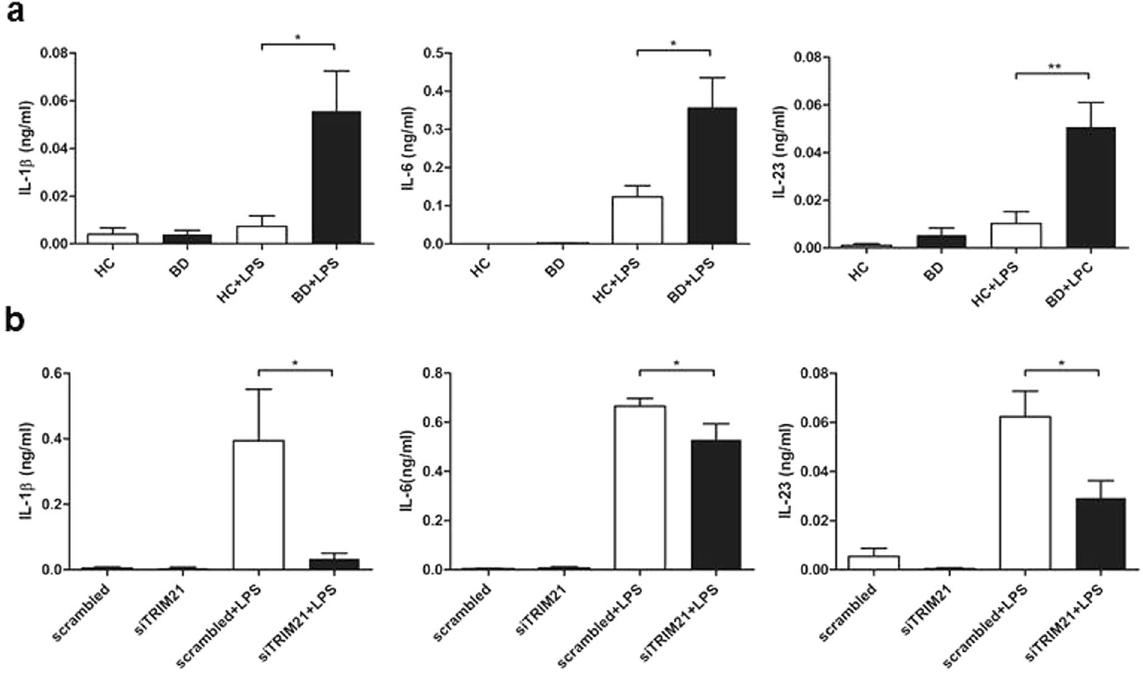
Figure 3. BD monocytes showed increased secretion of Th17-promoting cytokines, and knock-down of TRIM21 decreased cytokine secretion. ( a ) Monocytes isolated from healthy controls or BD patients were stimulated with LPS (1 µ g/ml) for 24 h. Supernatants were collected, and secretion of IL-1 β , IL-6, and IL-23 was measured by ELISA. ( b ) Primary monocytes from healthy controls were transfected with scrambled RNA or TRIM21 siRNA (10 nM) for 24 h, and the transfected cells were stimulated with LPS (1 µ g/ml) for 24 h. Supernatants were collected; and secretion of IL-1 β , IL-6, and IL-23 was measured by ELISA. Data are represented as the mean ± SD. * P < 0.05, ** P < 0.01 compared with LPS stimulation or TRIM21 knock-down in monocytes in healthy